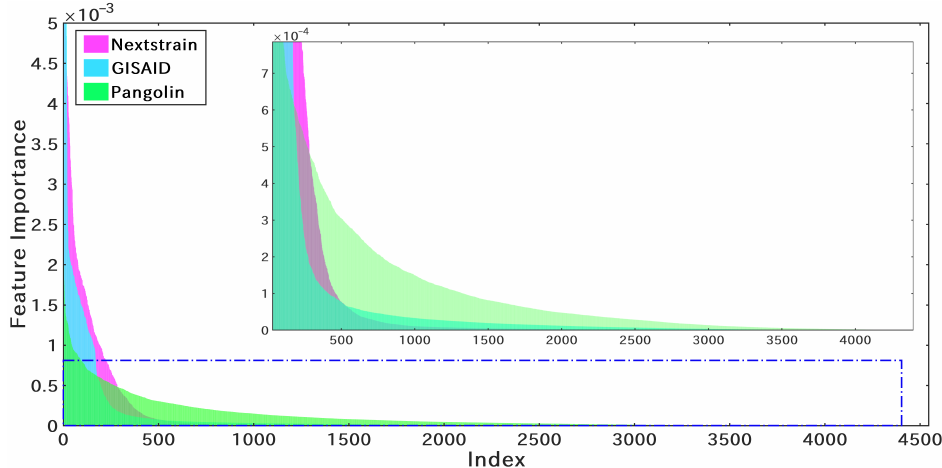
Figure 14. The feature importance distribution of three SARS-CoV-2 genome sequence typing strategies. The index is the result of sorting the sites in descending order of importance.